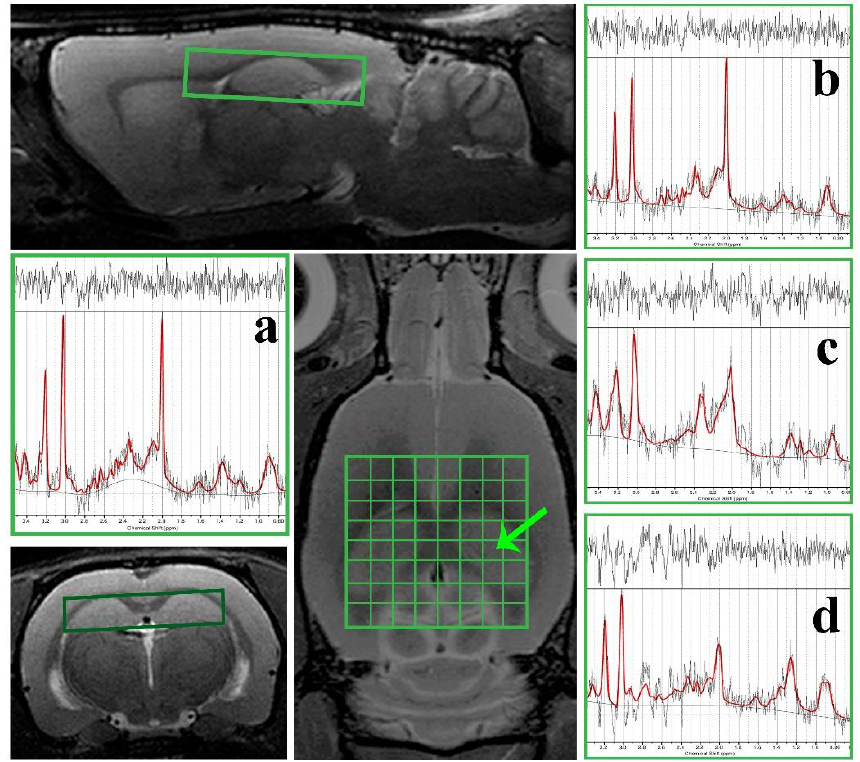
Figure 1. In vivo 1 H magnetic resonance spectroscopy (MRS) in the hippocampus of the rat brain. On the morphological T 2 -weighted MR images is shown the position of the CSI grid with real voxel size of 2.75 × 2.75 × 2 mm 3 covering the hippocampus (green labelling) of the rat brain. There are also displayed representative in vivo 1 H MRS-spectra in the rat hippocampus from control ( a ), Met-C ( b ), Met-IR-3d ( c ) and Met-IR-7d ( d ) groups evaluated in LCModel software (version 6.3-1K; S. Provencher, Ontario, Canada).